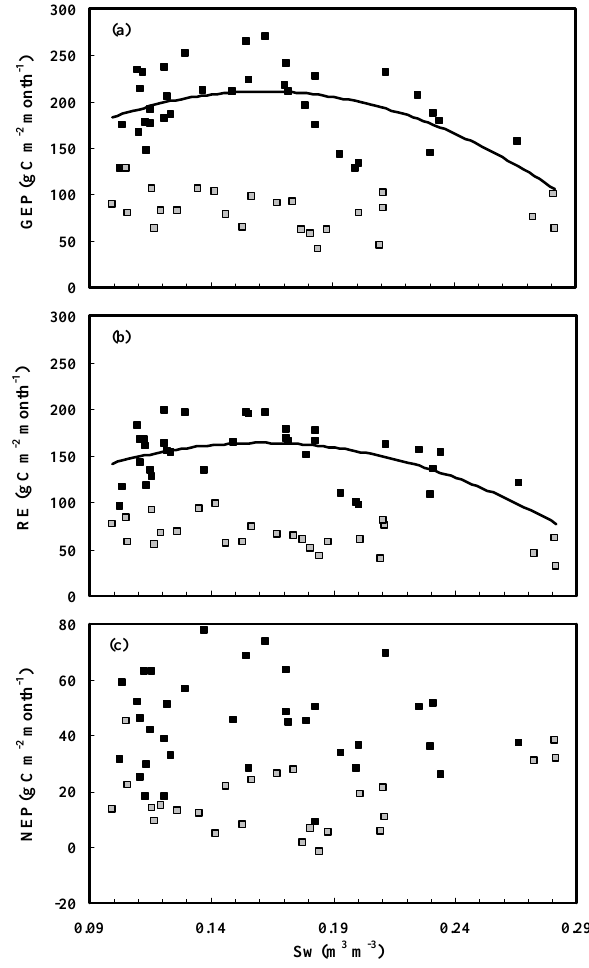
Fig. 5. Response of monthly gross ecosystem photosynthesis (GEP), ecosystem respiration (RE) and net ecosystem production (NEP) to soil water content (Sw, 5cm) during 2003 to 2007 at Qianyanzhou site. GEP, RE and NEP were marked by black squares while air temperature was larger than 16 ◦ , and gray squares while temperature less than 16 ◦ . Least-squares quadratic regressions of the data marked by the black squares were given by the solid line, and (a) R 2 = 0 . 17, p < 0 . 01 and (b) R 2 = 0 . 18, p < 0 . 01.